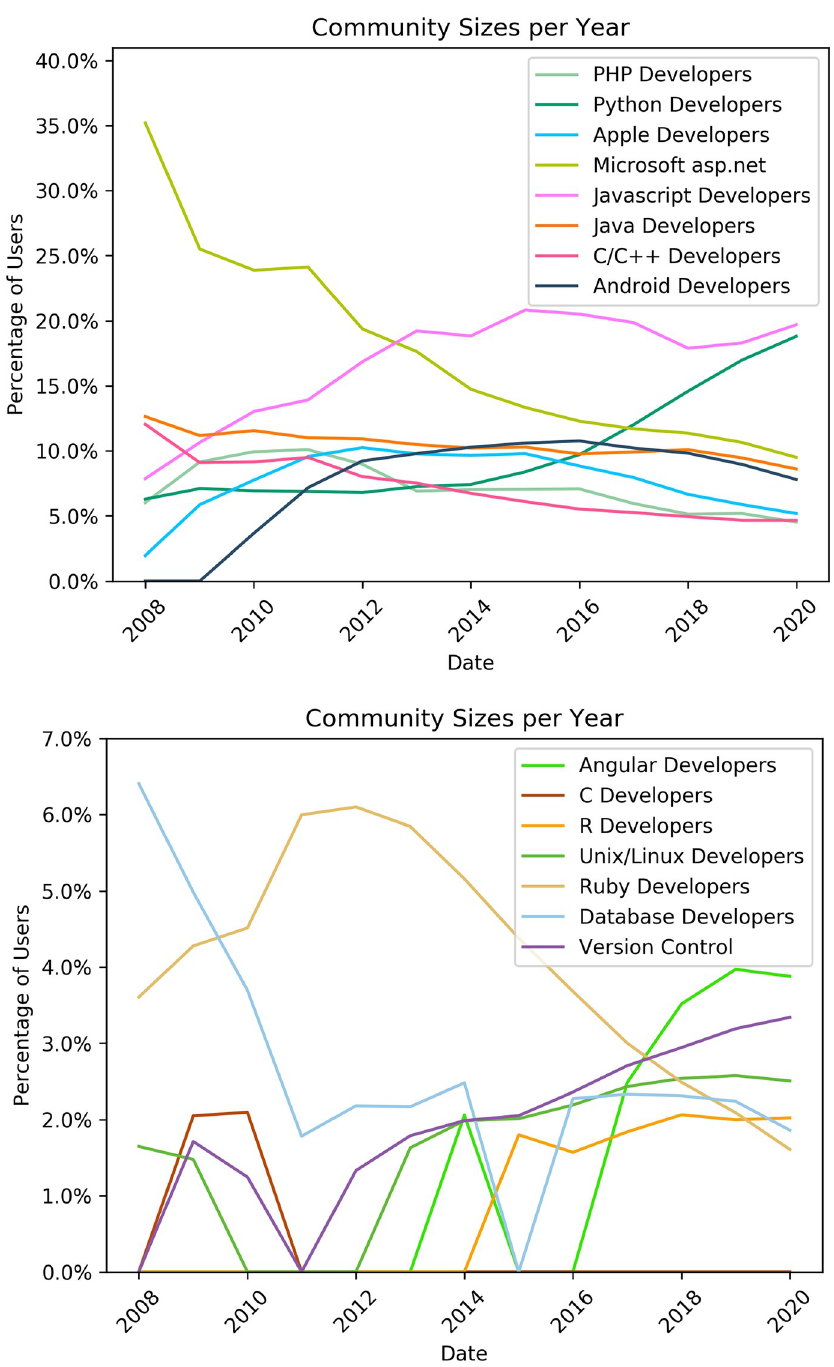
Fig 10. Evolution of community sizes over time. The time series present the percentage of all users on Stack Overflow that each detected community contains in each year from 2008 to 2020. Plots for the 15 largest communities are shown, smaller communities are omitted for